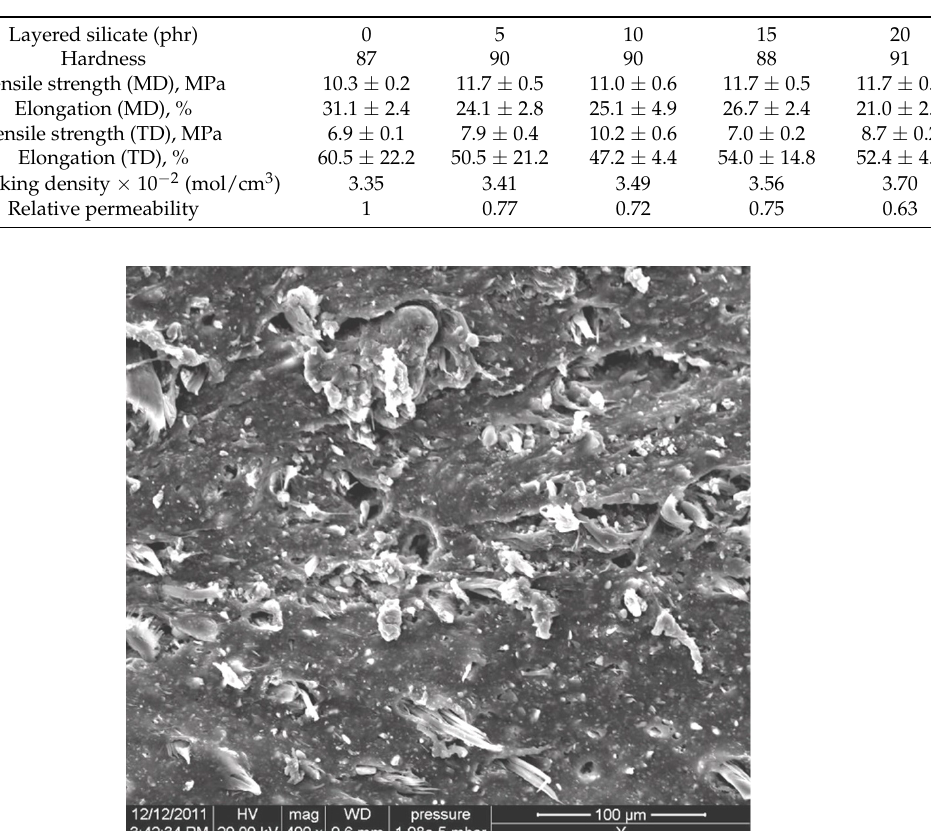
Table 1. Mechanical properties, crosslinking densities and triacetin (TA) permeabilities of layered-silicate reinforced EPDM/CR nanorubbers.